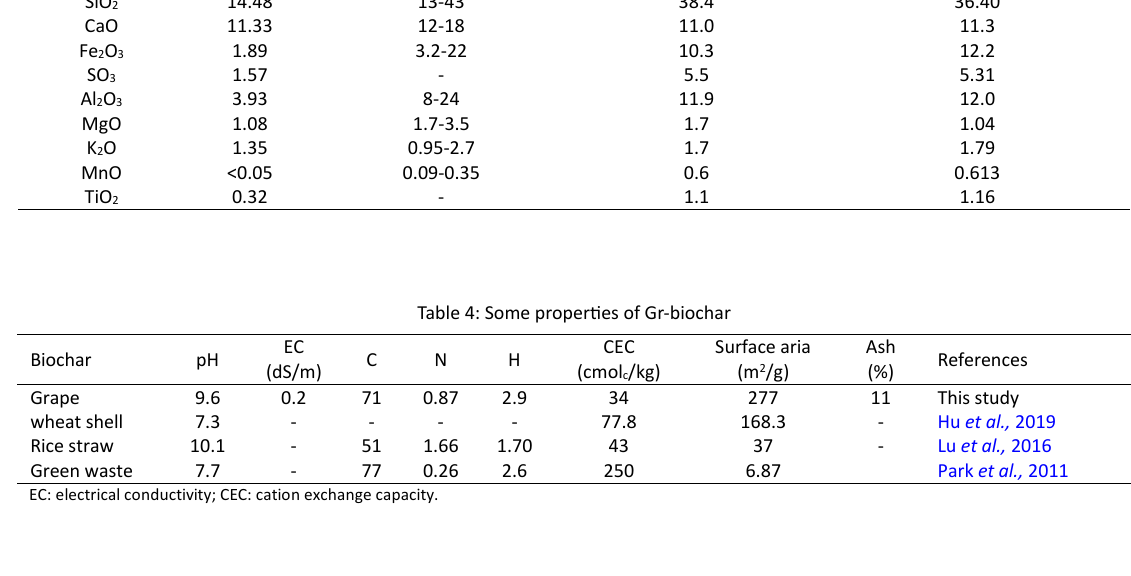
Table 5: Chemical analysis of composites (struvite:Gr-biochar)